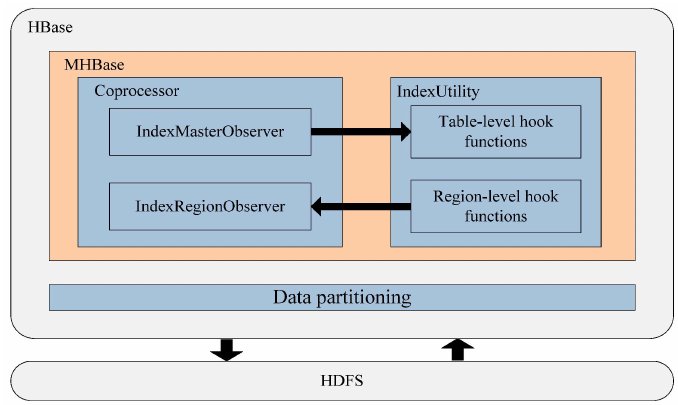
Figure 4. Architecture of